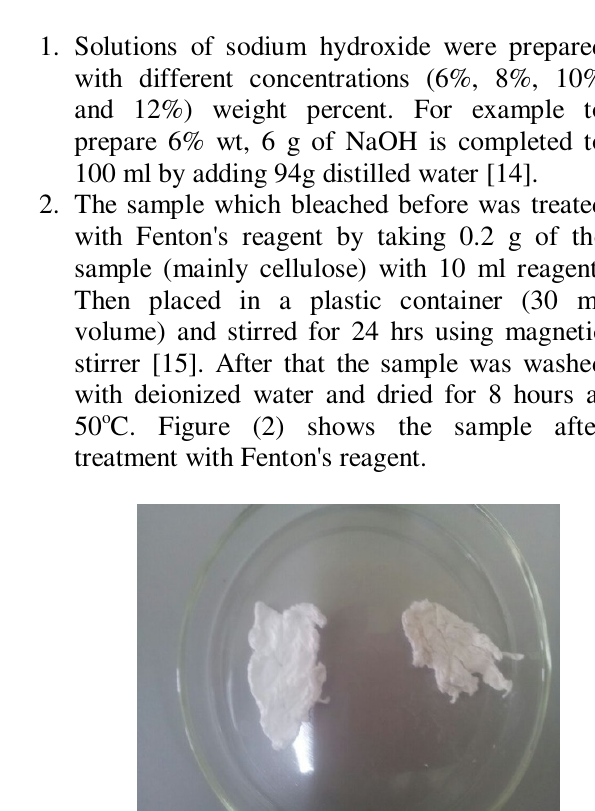
Fig. 1. The sample after bleaching.